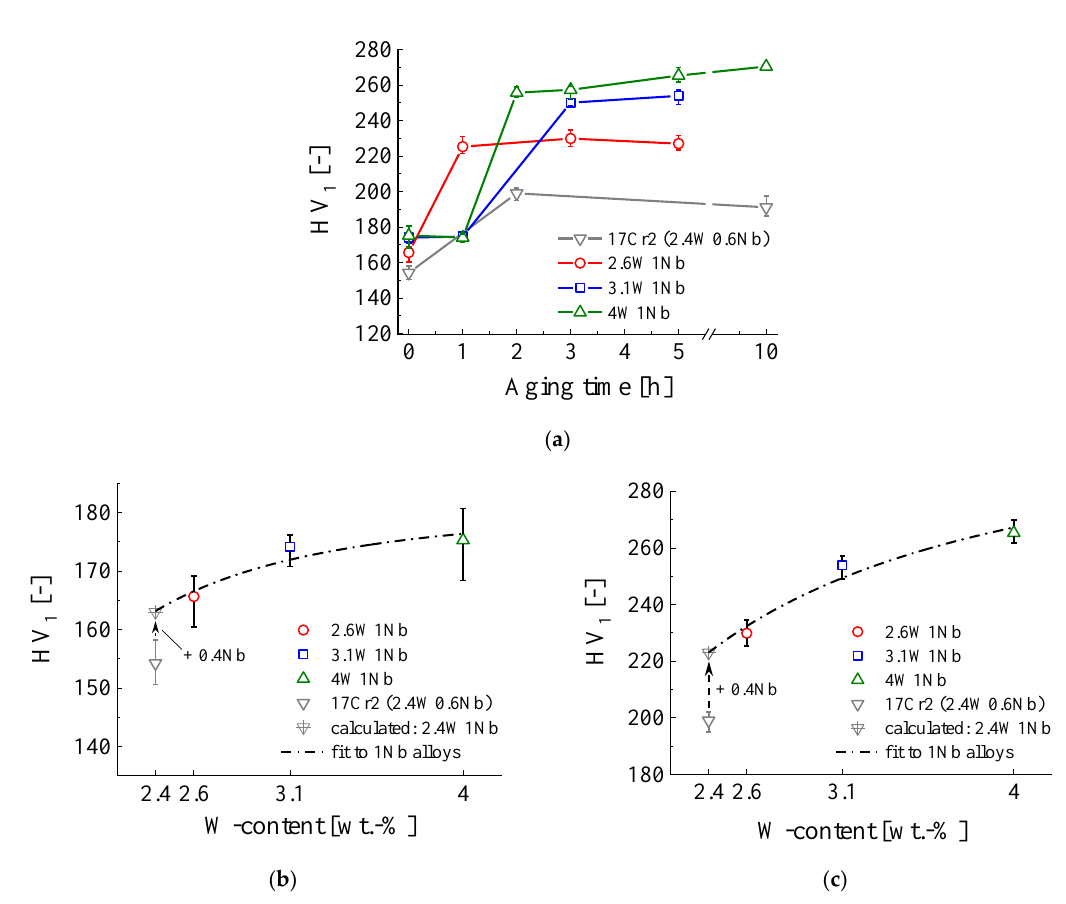
Figure 4. ( a ) Evolution (average of 5 measurements each) of the base and trial alloys in annealing at 650 °C. ( b ) Impact of W- and Nb-contents on hardness in the solution annealed state (virtual 2.4W1Nb alloy calculated by eliminating the effect of W by backward extrapolation of the 1 Nb alloys, equation: HV 1 = a × (1 − c W−b ); c W : W-content in wt.%, a: 180.73, b: 2.68); and after 5 h of aging ( c ) ( equation: HV 1 = a × (1 − c W−b ); c W : W-content in wt.%, a: 305.47, b: 1.45). In the solution annealed state (i.e., 0 h in Figure 4a,b), the additions of Nb and W both benefited solid solution strengthening. An attempt to calculate the e ff ect of sole Nb-addition to the base steel (17Cr2 (2.4W0.6Nb) + 0.4 wt.% = fictious 2.4W1Nb) by mathematical backward extrapolation (cf. Figure 4b) of the e ff ect of tungsten content to 2.4 wt.% yielded a 6% rise in hardness up to 163 HV 1 (from 154 HV 1 in case of the 2.4W0.6Nb base steel) for the virtual 2.4W1Nb alloy. The addition of 0.2 wt.% W resulted in a further increase to 166 HV 1 in the case of the 2.6W1Nb material. Rising W-content resulted in values of 174 HV 1 (3.1W1Nb) and 175 HV 1 (4W1Nb) equaling another gain by 7%. The encountered substitutional e ff ect of W on ferrite hardness correlates well with literature data [19]. The influence of Nb- and W-contents on hardness in the short-term aged state ◦ (i.e., precpitatation annealed at 650 C for 5 h) is displayed in Figure 4c. The plateau hardness values of the alloys are sensitive to both the Nb and W concentrations. After 5 h of aging, the hardness increase of the virtual 2.4W1Nb alloy calculated to 223 HV 1 . In comparison to 210 HV 1 measured at the 2.4W0.6Nb alloy, this gave a rise by 6% with the increase of 0.4 wt.% in Nb-content. Progressively adding W provided a gain to 230 HV 1 (2.6W1Nb), 254 HV 1 (3.1W1Nb), and 265 HV 1 (4W1Nb); equaling another overall incremet of